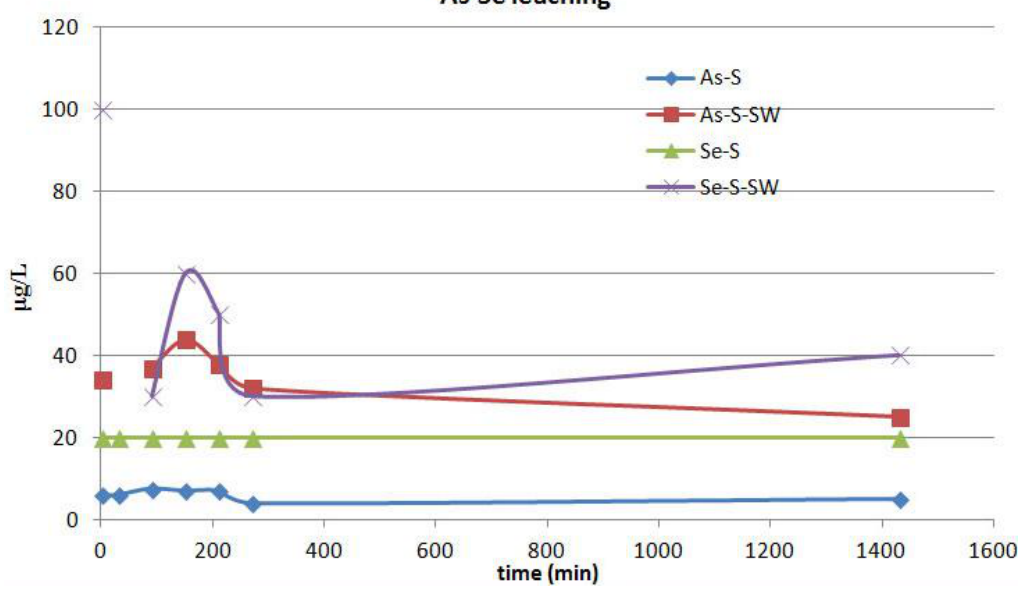
Figure 4. Evolution of As and Se in the pilot-scale experiments. Values in μg/L. As/Se-S: change of As and Se content in time, measured in effluent solution of not-amended experiment, As/Se-S-SW: change of As and Se content in time, measured in effluent solution of amended